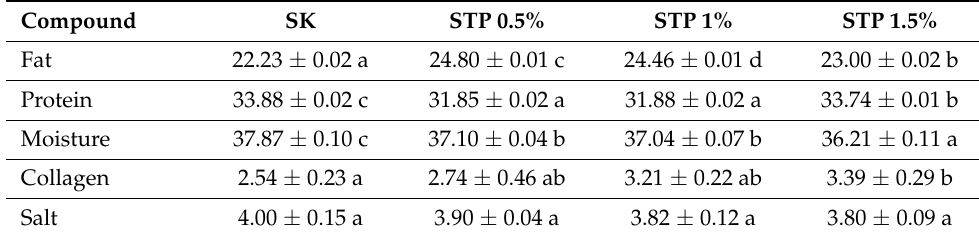
Table 2. Proximate chemical composition (%) of dry fermented sausages.